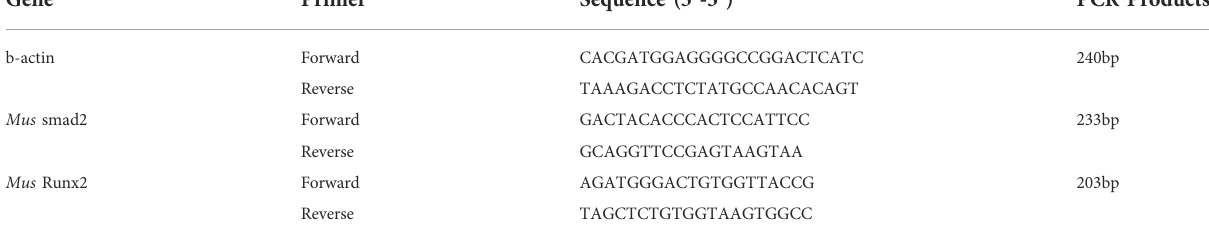
TABLE 2 Primer sequence